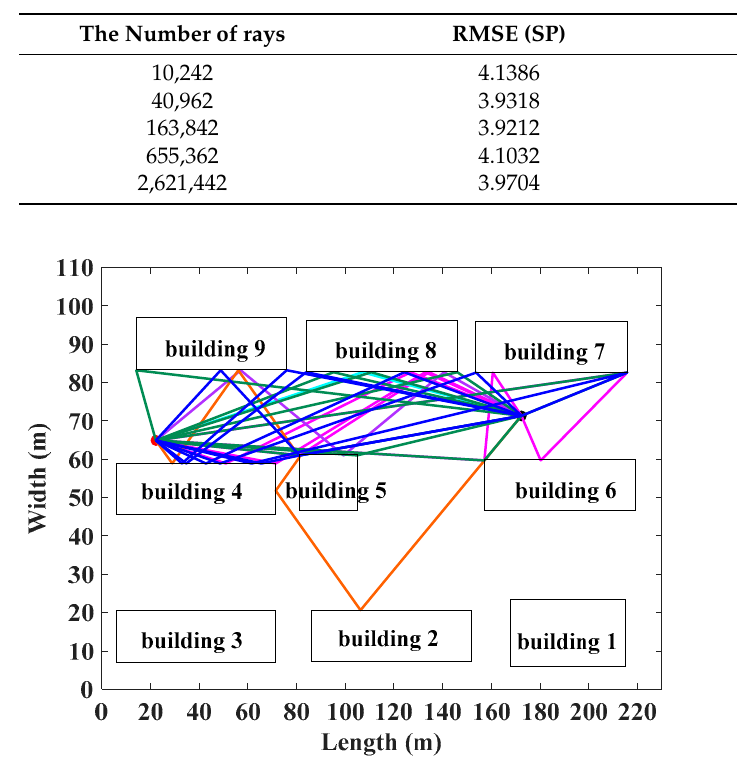
Figure 14. Visualization of the propagation path in a 2D surface at 172.3 m in the LOS.